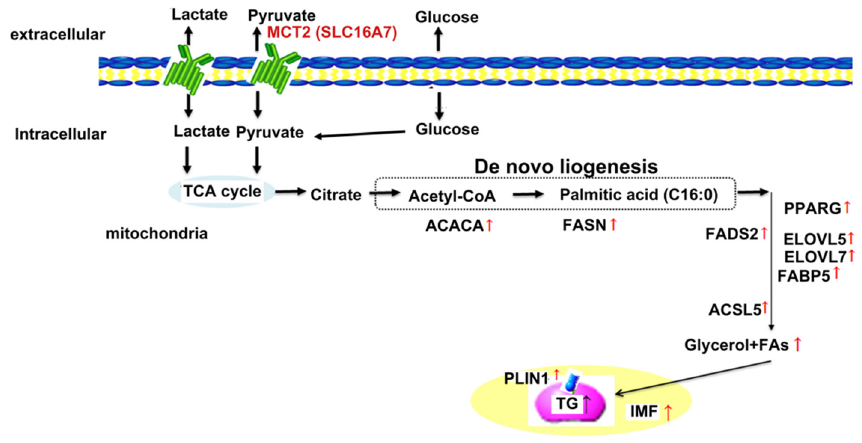
Figure 5. Potential metabolic pathways affecting TG synthesis of breast muscle in chicken. The black solid arrows indicate reported regulatory relationships.